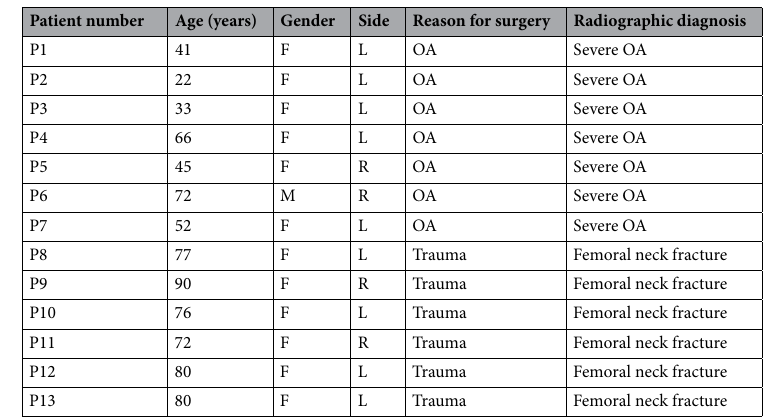
Table 1. Relevant clinical data collected from patients at the time of